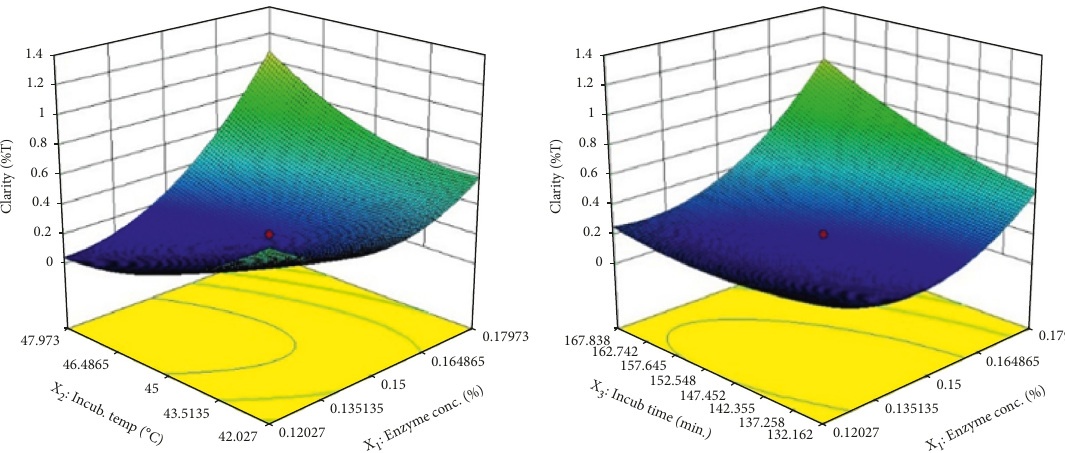
Figure 5: 3D graph plots displaying the interactive effect of factors on clarity (%T) of sapodilla